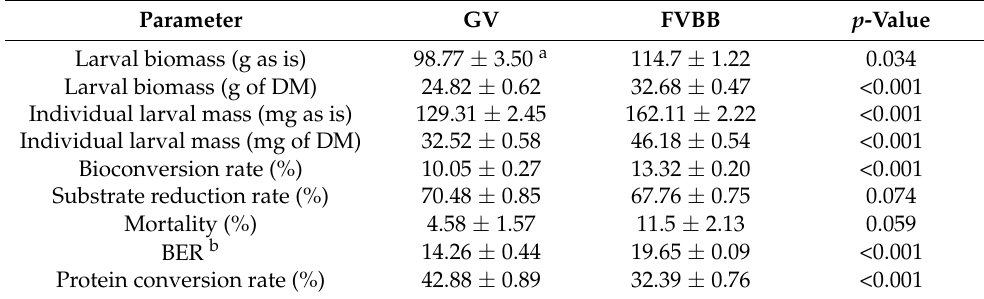
Table 2. Larval growth and substrate reduction efficiency of BSFL reared on the Gainesville (GV) and the fruit/vegetable/bakery/brewery (FVBB) diets.